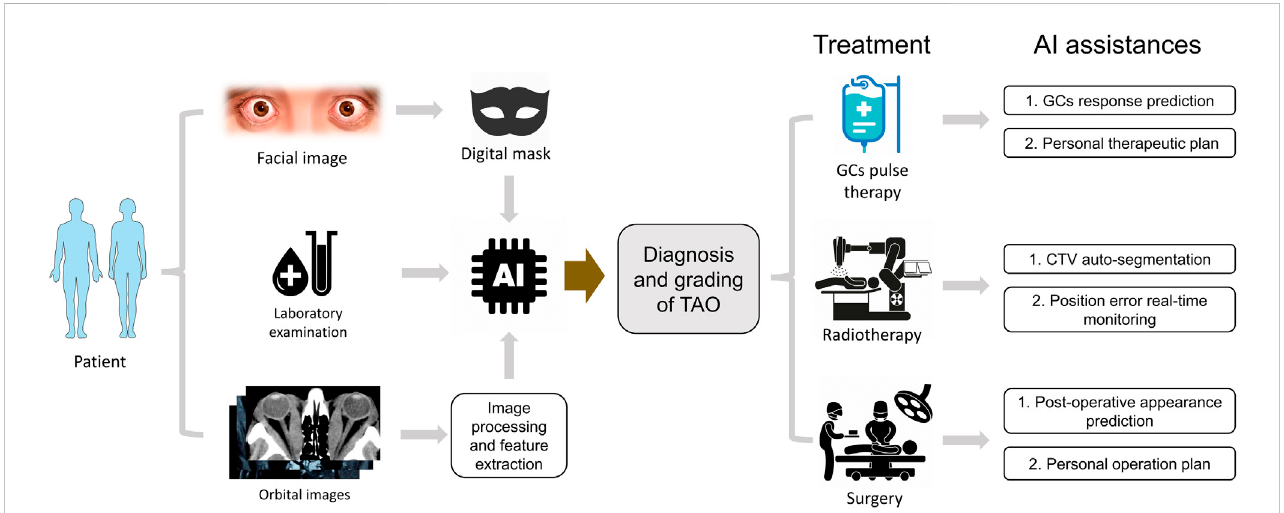
FIGURE 1 The hypothetical pattern of AI applications in TAO clinical practice. The diagnosis and grading of TAO could be deduced by an integrated AI module based on masked appearance, laboratory index and processed orbital images. The different therapy options could be optimized by AI assistances